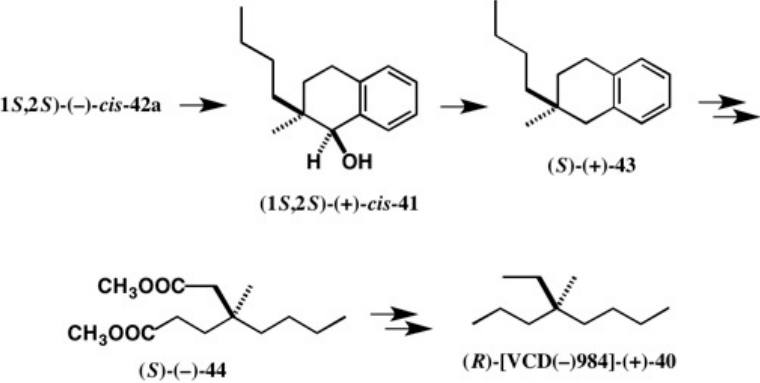
Figure 29. Synthesis of cryptochiral hydrocarbon ( R )-[VCD( − )984]-(+)- 40 starting from CSDP ester (1 S ,2 S )-( − )- cis - 42a .